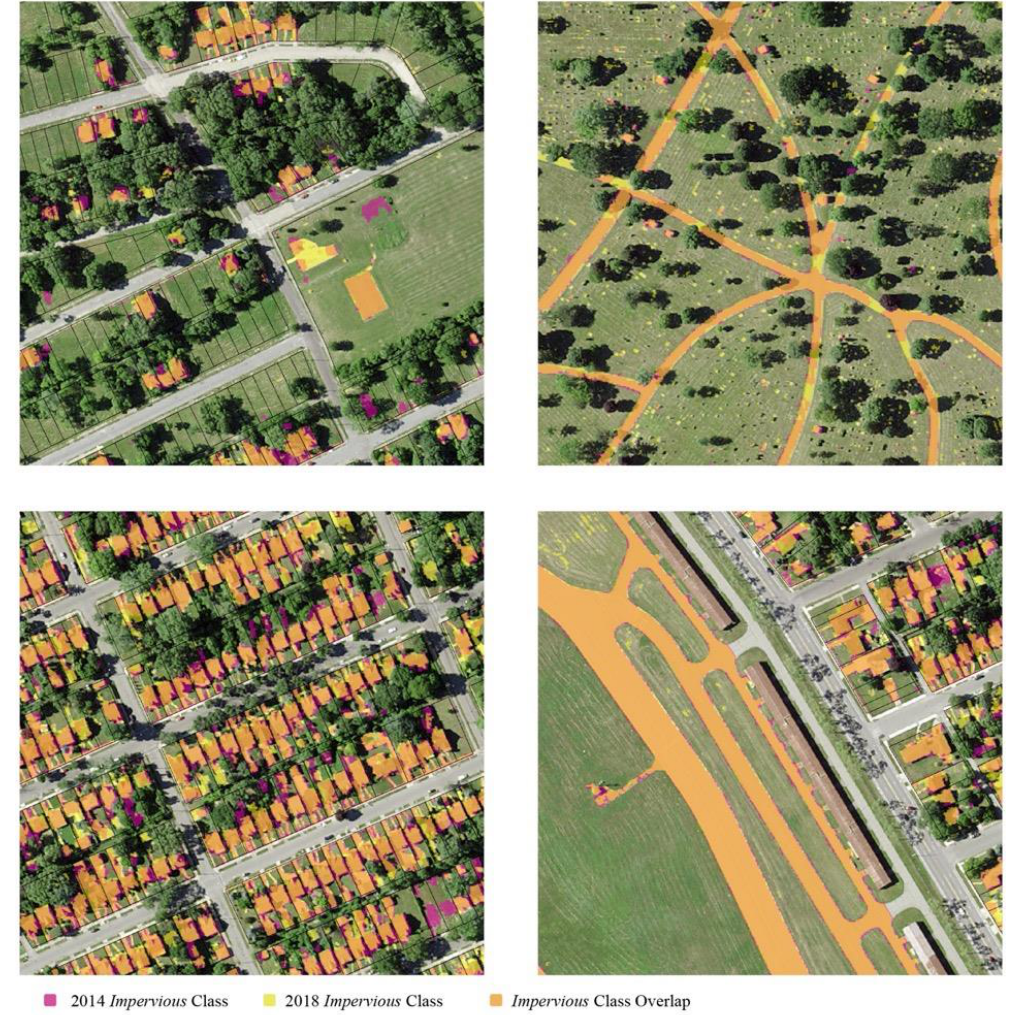
Figure 15. Impervious surface overlap on parcel lots .